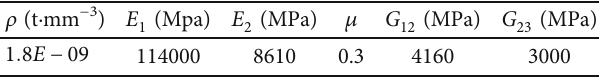
Table 4: T700/epoxy composite properties [9,